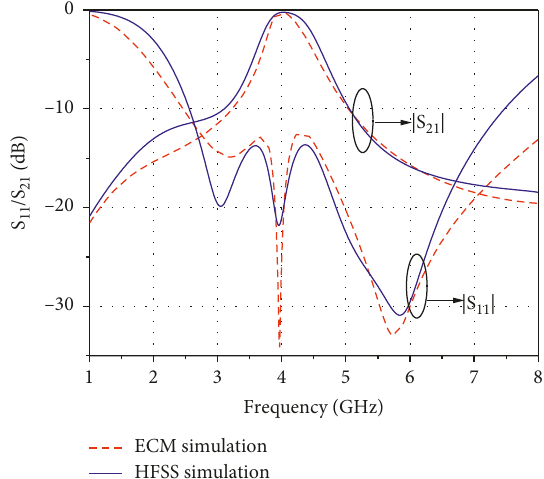
Figure 4: Surface current distributions of the TLLE at different operating frequencies. (a) f resonant frequency, and (c) f A2 : higher absorption frequency.